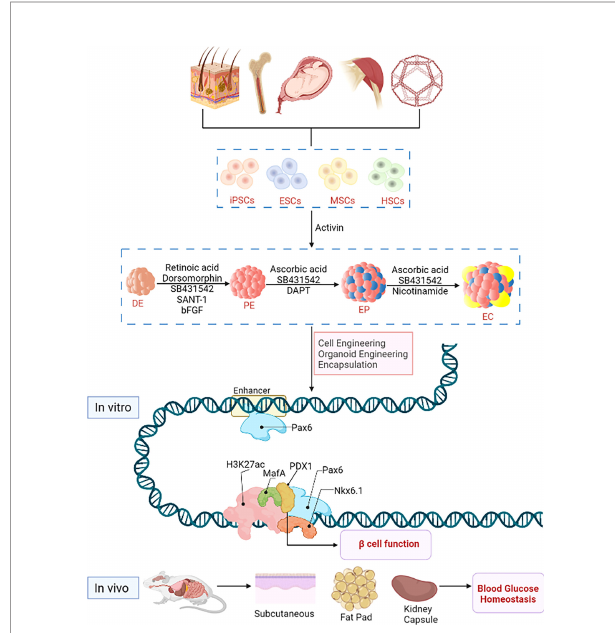
FIGURE 1 | Stem cell engineering for type 1 diabetes. Stem cells originate from various sources, e.g. embryonic stem cells with strong ability of differentiation and self-renewal from embryonic tissues, hematopoietic stem cells and bone marrow stem cells from tissues or organs such as placenta, amniotic fl uid, umbilical cord, bone, skeletal muscle, fat and skin; induced pluripotent stem cells are produced by genetic reprogramming of somatic cells. In vitro , predicted paired box 6 (PAX6) activates the expression of pancreatic b -cell-speci fi c genes and proteins, such as pancreatic duodenal homeobox factor-1 (PDX-1) and NK6 Homeobox 1, (NKX6-1) and musculoaponeurotic fi brosarcoma oncogene family A (MafA), and interacts with these factors at the protein level to promote b -cell function. In vivo , hypoglycemic homeostasis is rapidly reestablished in diabetic immunode fi cient mice (NOD/SCID) after transplantation with subcutaneous, renal capsule or fat